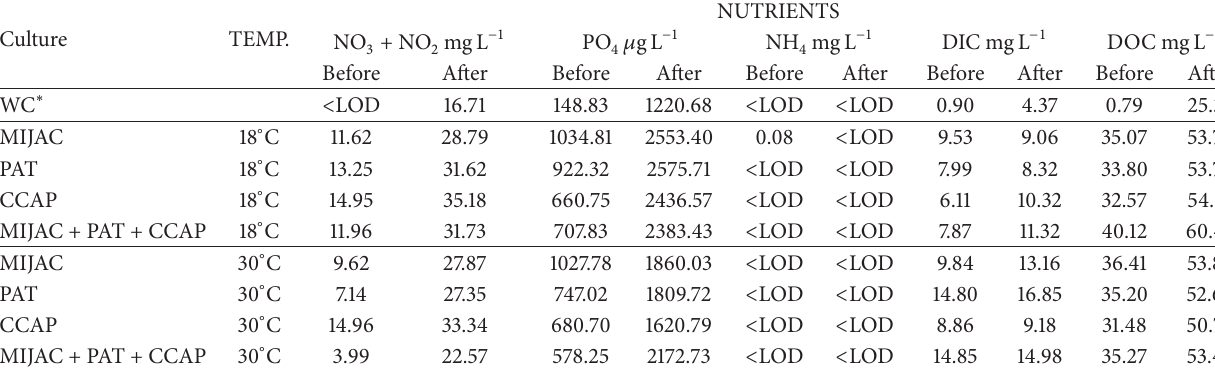
Table 2: Nutrient concentrations of cells free culture filtrate of M. aeruginosa (MIJAC), P. agardhii (PAT), C. meneghiniana (CCAP) and three culture (MIJAC + PAT + CCAP) at 18 ∘ C and 30 ∘ C, before and after nutrients replenishment. LOD: level of detection. LOD for NO 3 + NO 2